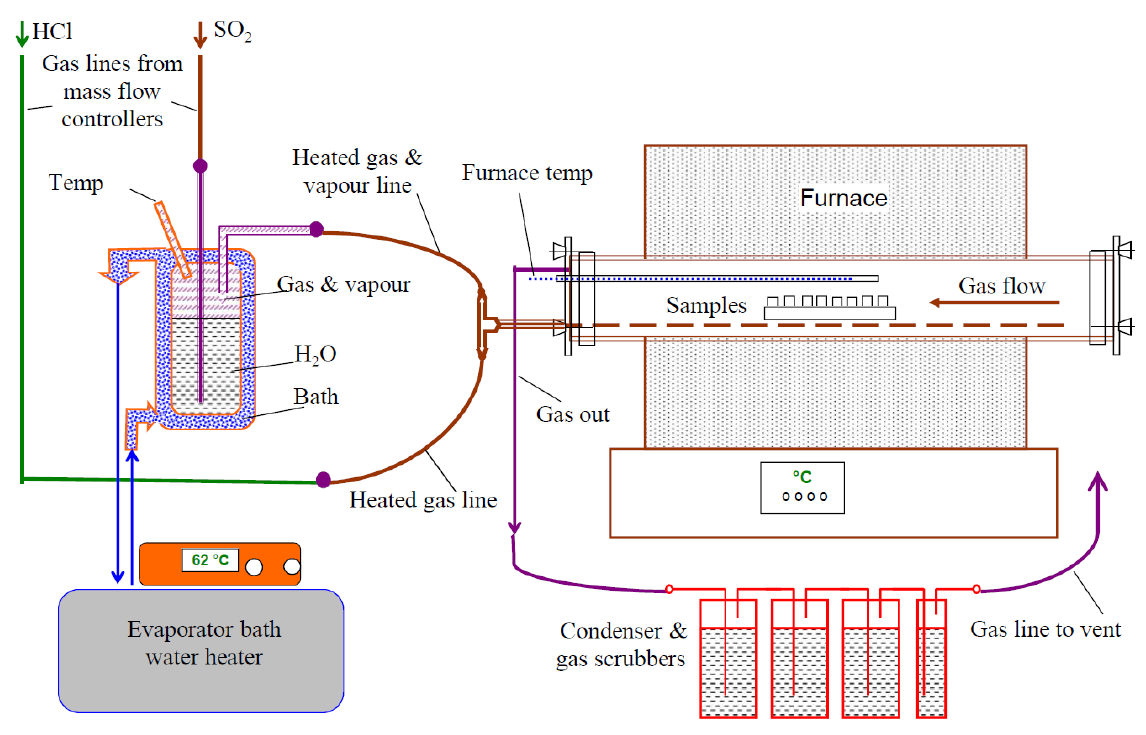
Figure 3. Schematic figure of the high temperature corrosion test